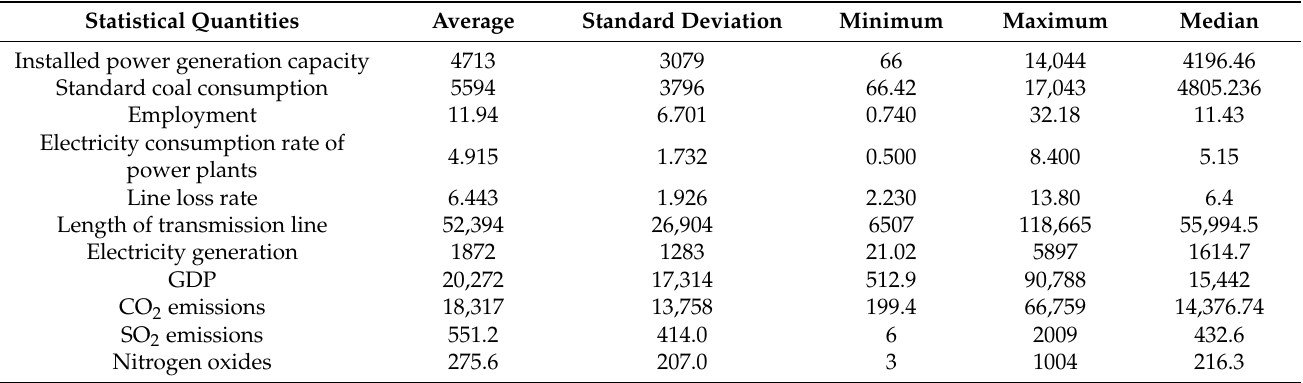
Table 2. Descriptive statistics of environmental performance indicator variables in the power